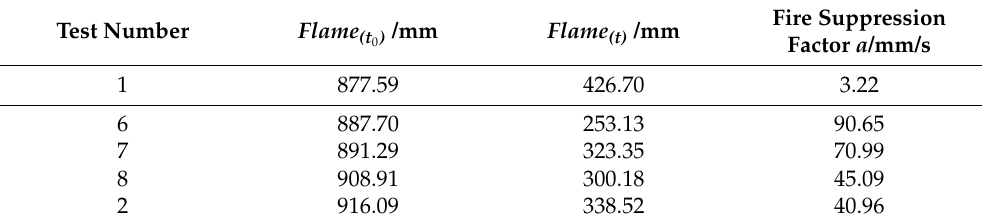
Table 7. Fire suppression efficiency at different pipe diameters.